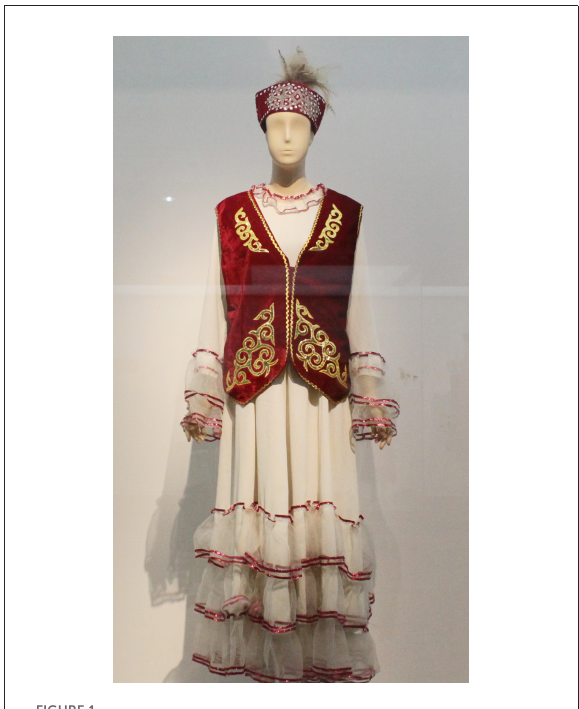
FIGURE1 Garment in Kazakh. Figures 1, 2, 4, 5 are photoed by the author in Museum. Figures 1, 2 are from Capital Museum; Figure 3 is from Jeong (1997); Figure 4 is from Xinjiang Uighur Region Museum; Figure 5 is from Aksai Kazakh National Museum.